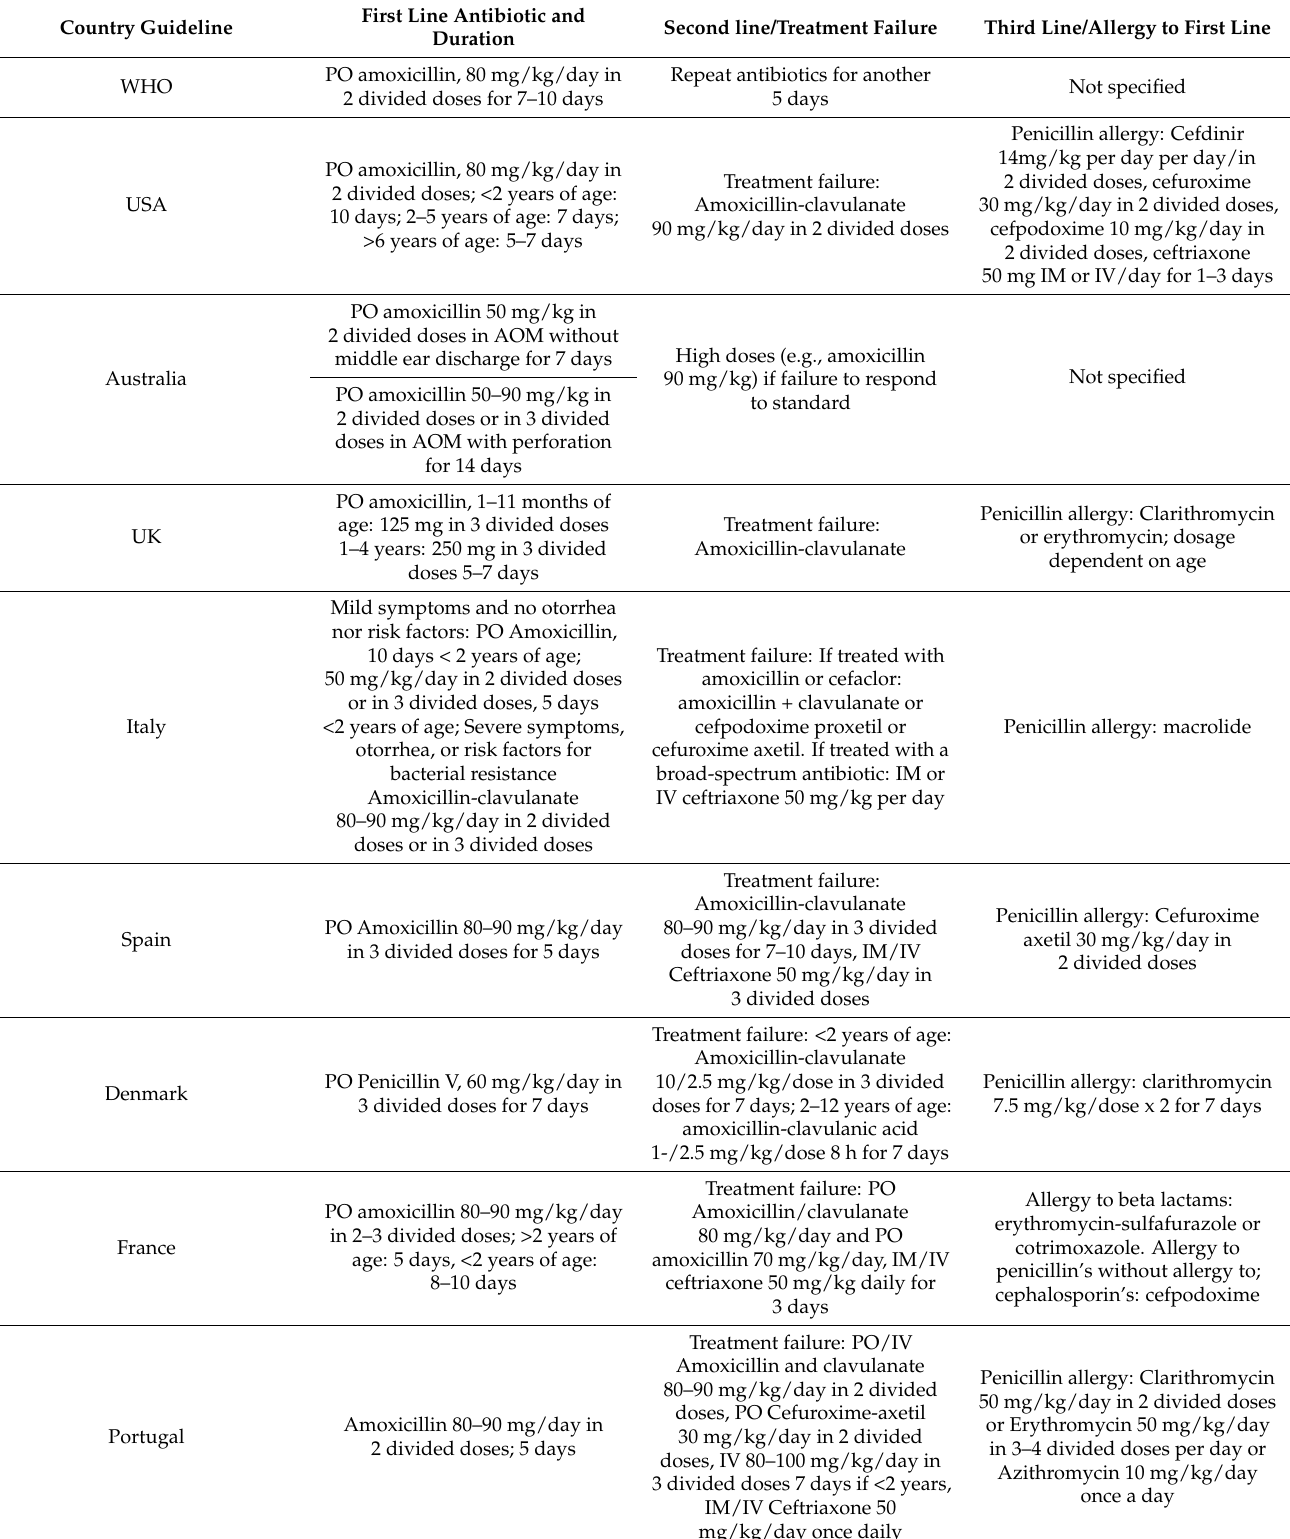
Table 4. Antimicrobial treatment